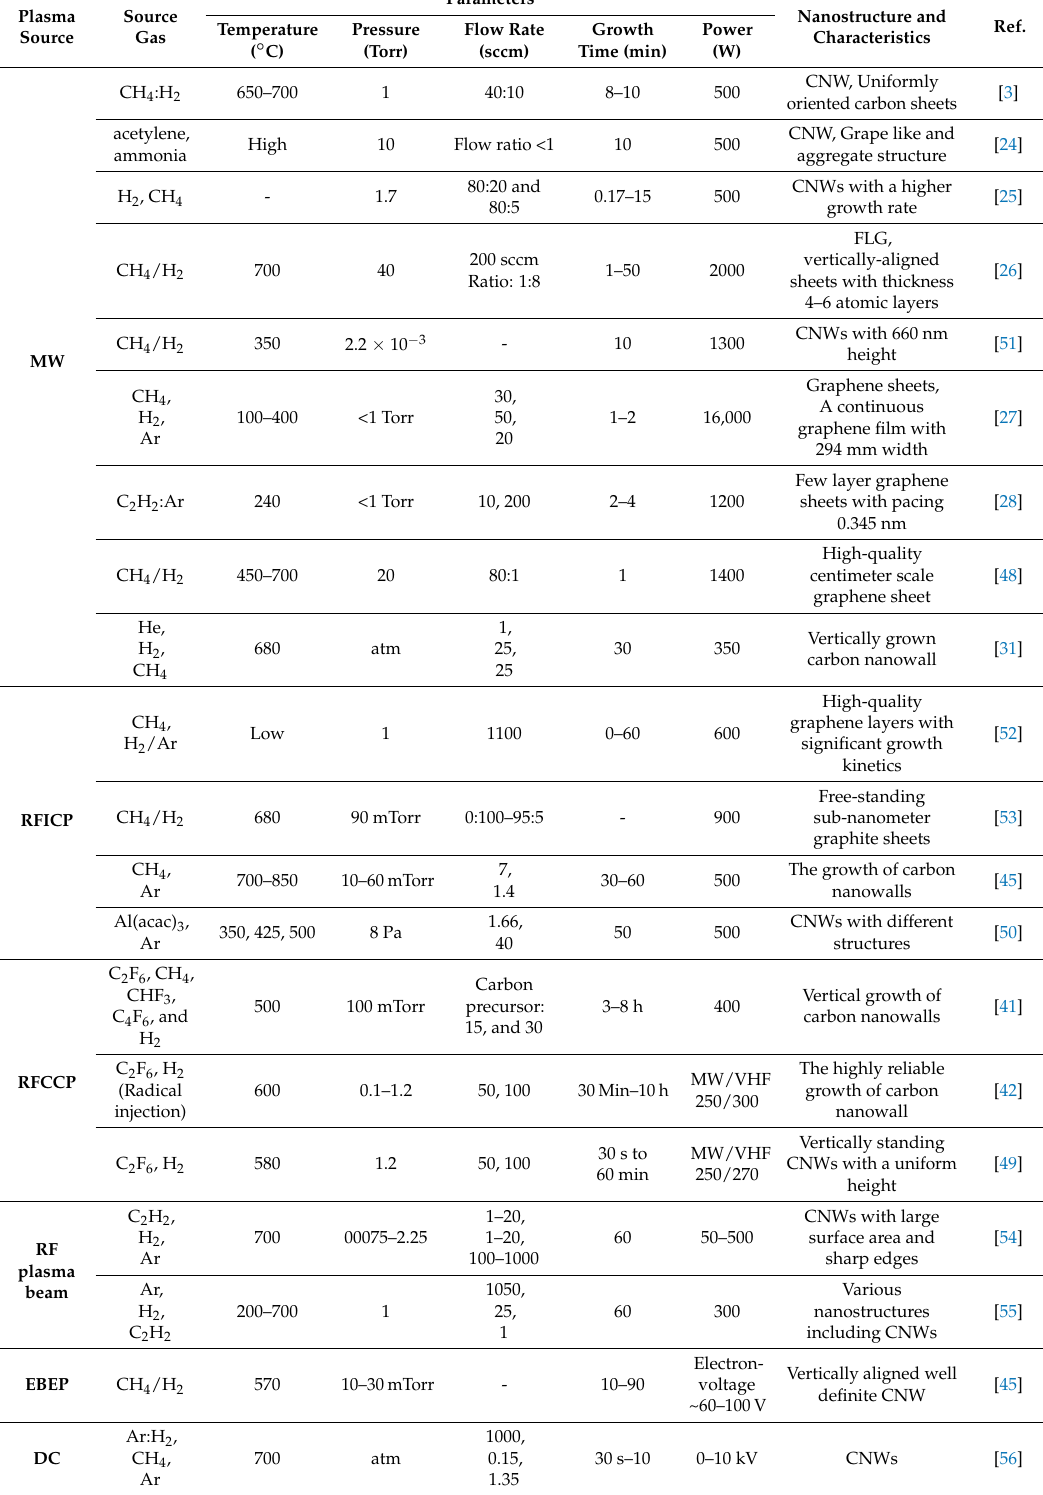
Table 1. Overview of plasma-enhanced syntheses for different two-dimensional (2D) carbon nanostructures